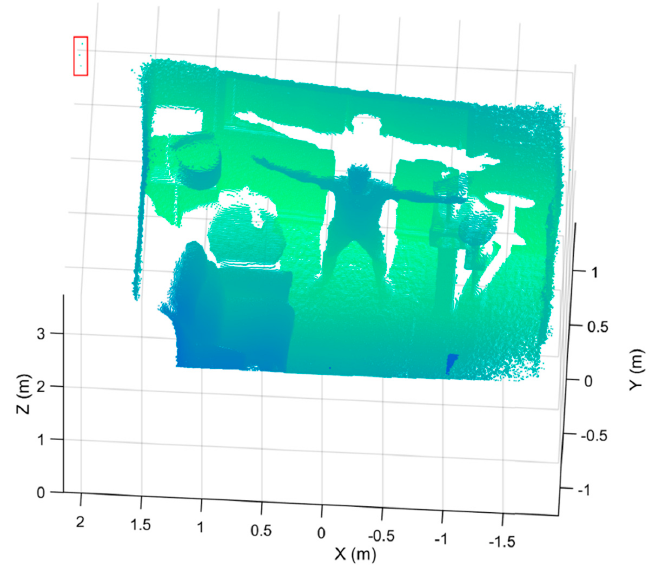
Figure 2. A sample point cloud with false data points (surrounded by a red rectangle), detected as the noise outside the true boundaries of the room. These noise artifacts artificially expand the overall outer dimensions of the point cloud.